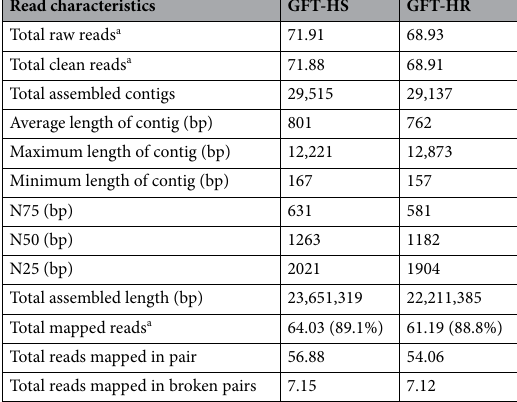
Table 1. Statistics for the RNA sequencing and de novo assembly of herbicide-susceptible (HS) and -resistant (HR) green foxtail (GFT) biotypes. a Reads = × 1,000,000.